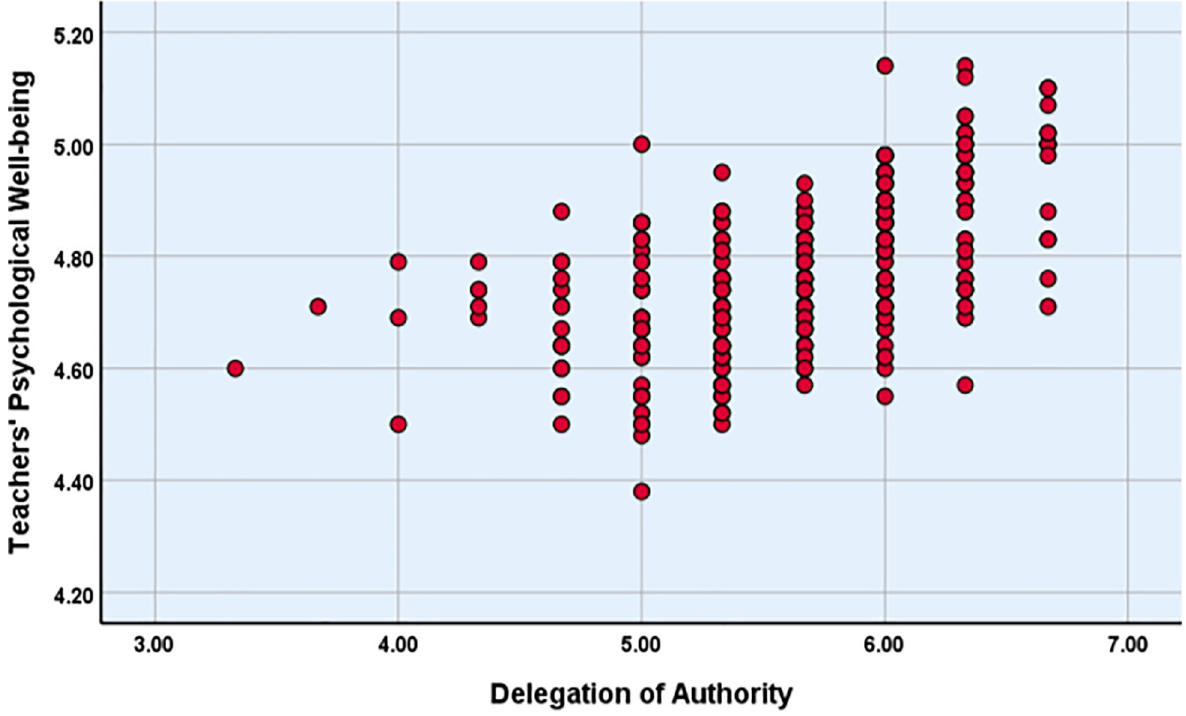
Fig 3. Pearson’s product-moment correlation between delegation of authority and teachers’ psychological well-being. The scatterplot plainly reflects the significant positive relationship between delegation of authority (subdomain of leadership empowering behaviour) and Teachers’ psychological well-being at secondary